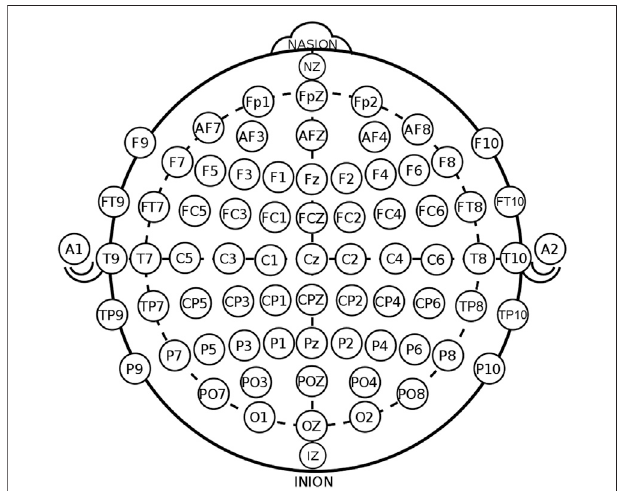
FIGURE 1 | International 10-20 System for EEG-MCN by Oxley, B.C. (2020) 2